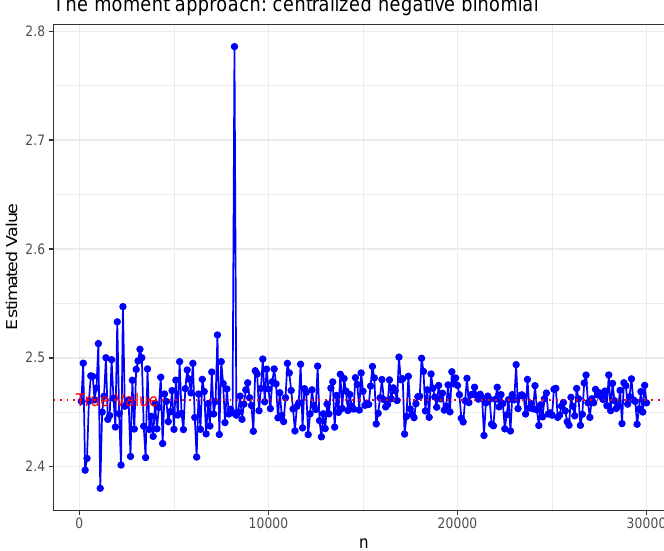
Figure 4. centralized negative